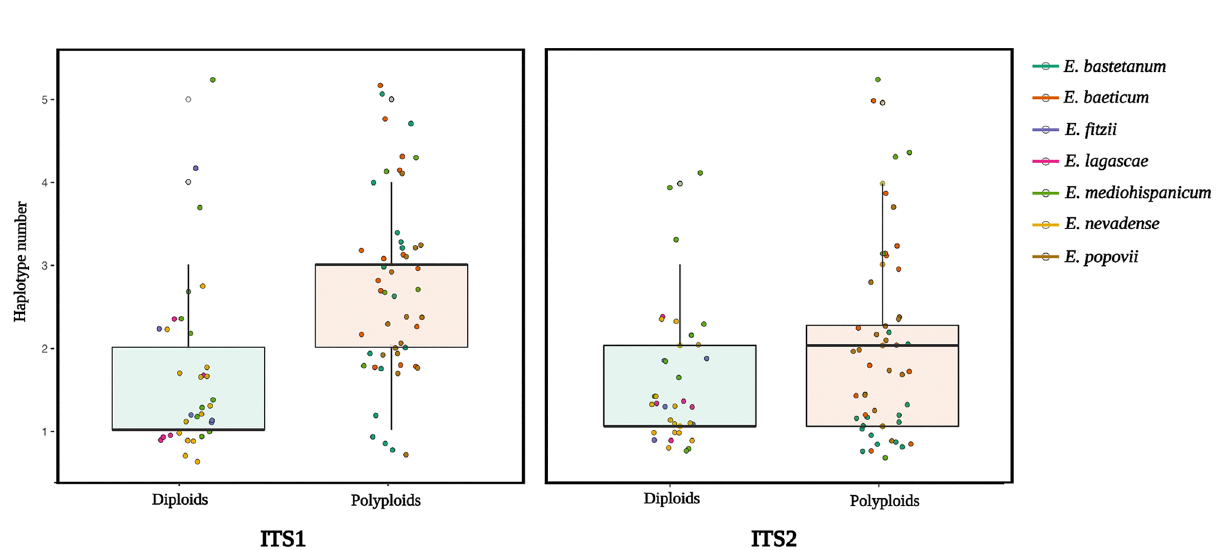
Figure 2. Boxplot depicting the number of ITS1 (left) and ITS2 (right) haplotypes per sample for diploid and polyploid